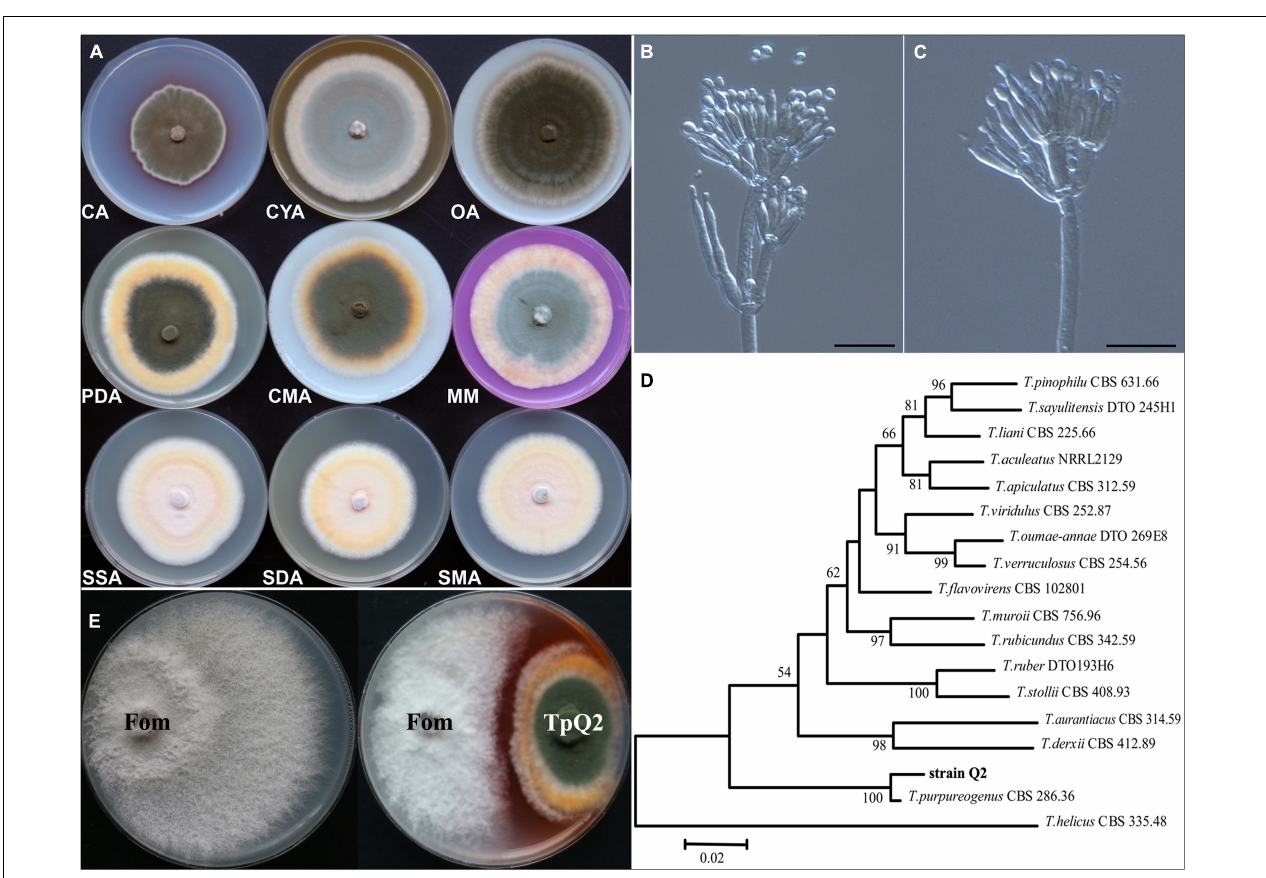
FIGURE 1 | Morphologic and molecular identification of TpQ2 and its antagonistic effect on Fom growth. (A) Colonies of TpQ2 on different culture medium plates at 25 ◦ C after 7 day incubation. CA, Czapek agar; CYA, Czapek yeast extract agar; SMA, Sabouraud maltose agar; CMA, Corn meat agar; MM, Martin medium; SSA, Sabouraud sucrose agar; SDA, Sabouraud dextrose agar; OA, Oatmeal agar. (B,C) Morphology of TpQ2 conidiophore observed under a light microscopy. Scale bar = 20 µ m. (D) The best-scoring Maximum Likelihood tree was constructed using the MEGA7.0 plateform and the combined data set containing partial internal transcribed spacer ( ITS ), beta-tubulin gene ( BenA ), and calmodulin gene ( CaM ) sequences. This phylogenetic tree shows the relationships of TpQ2 with other members in Talaromyces . The bootstrap support percentages are indicated at the nodes. The bootstrap support values at less than 50% are not shown. (E) Antagonistic effect of TpQ2 on Fom growth on culture medium